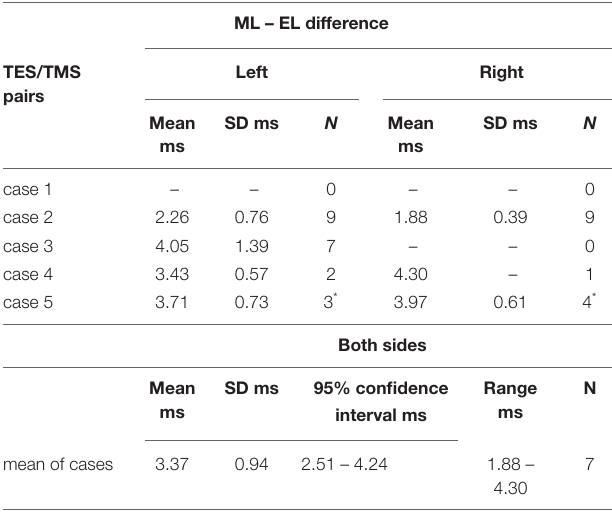
TABLE 3 | Overview of MEP latency differences ML–EL of TMS and TES after separation of latency times originating from the indirect SAN conduction